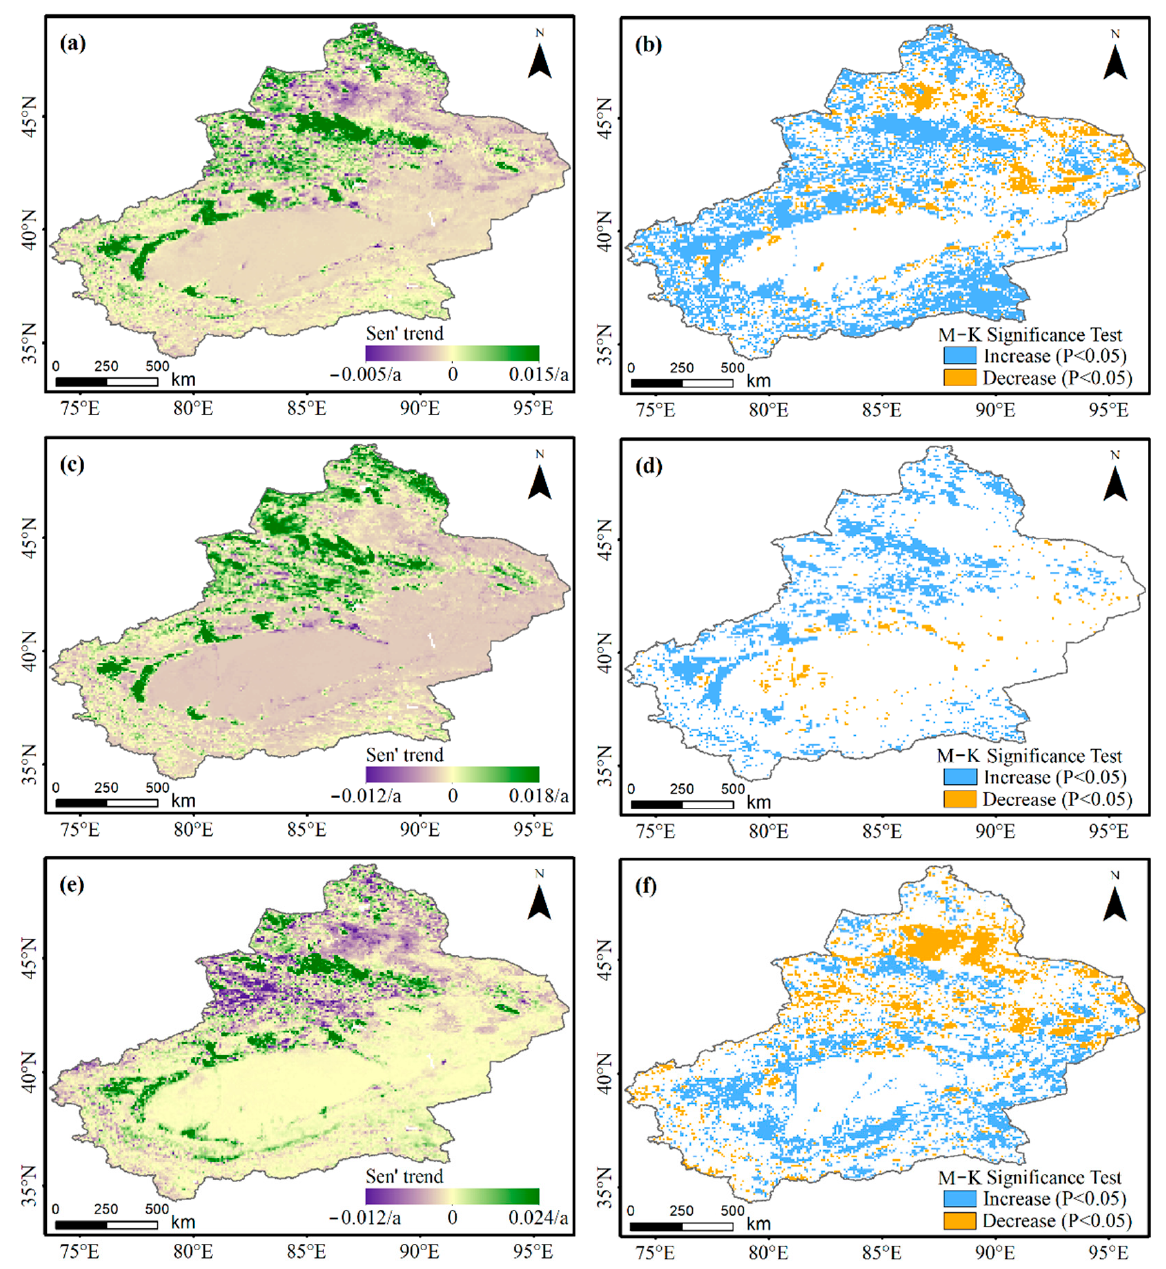
Figure 5. NDVI trends (left) and M–K significance test (right) over the GS in Xinjiang, China, from 1982 to 2015 ( a , b ); as well as the two periods of 1982–1996 ( c , d ) and 1997–2015 ( e , f ). The summer NDVI increased significantly from 1982 to 1996 (slope = 0.0007, R 2 = 0.34, p < 0.05), but no increase or decrease was observed after 1996 (slope = 0.0004, R 2 = 0.25, p > 0.05) (Figure 4c). By comparison, the increase in NDVI was more pronounced in the summer season than in the growing season. We also compared the spatial patterns of NDVI trends before and after TP (1996) (Figure 6). From 1982 to 1996, the maximum NDVI was greater in the summer (NDVI = 0.025) compared with the growing season. In addition, the decline of the NDVI trend occurred over a larger scale in summer than in the growing season, including most of the Tarim Basin and Turpan–Hami Basin (Figure 6c,d). However, after 1996, the area of delaying NDVI trends decreased more in summer than in the growing season (Figure